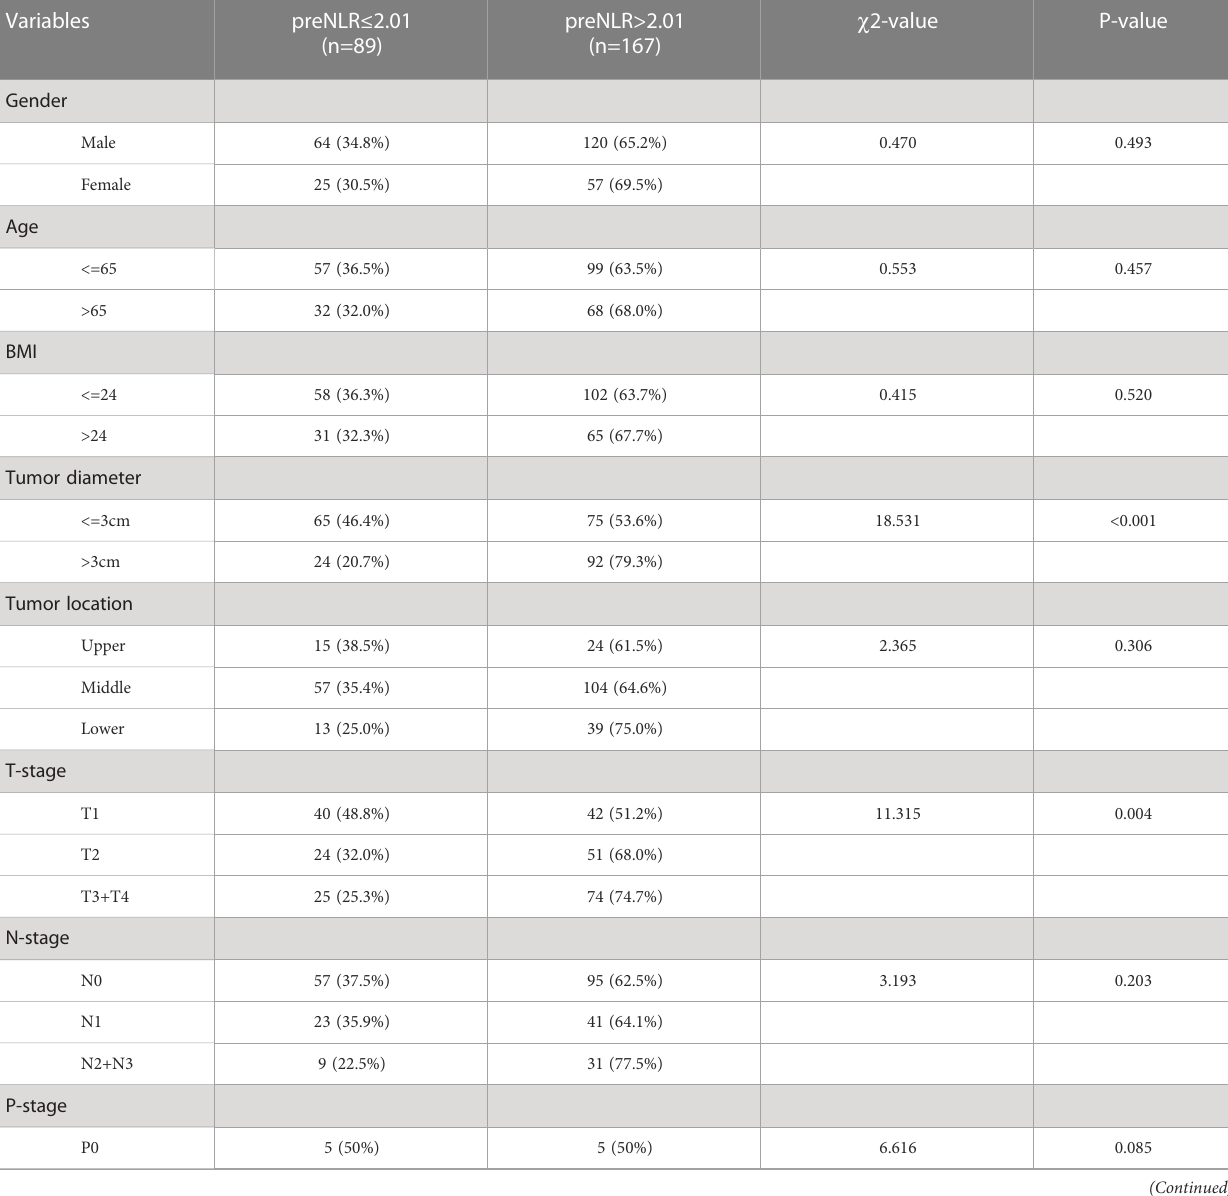
TABLE 3 Clinical characteristics of patients with different preNLR